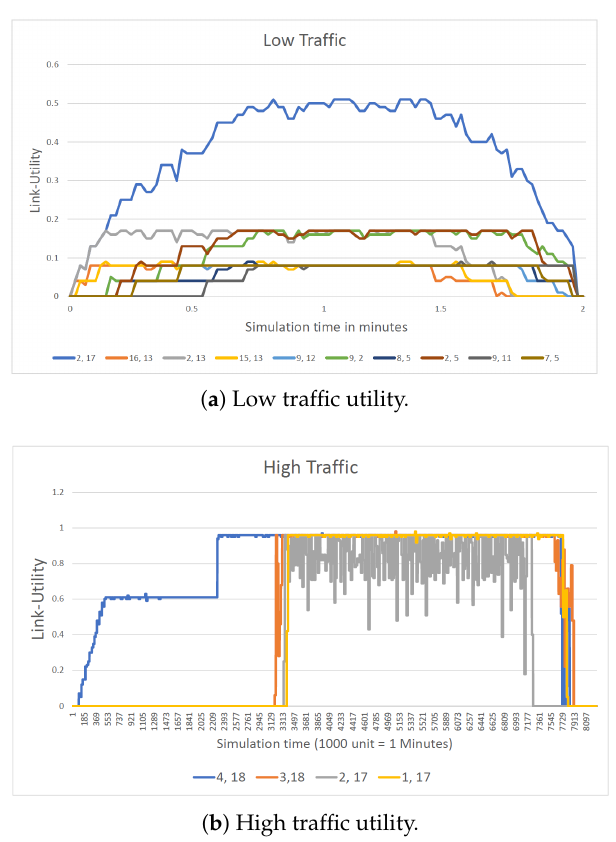
Figure 4. The link utilization is illustrated for both scenarios. The utility is less than the threshold for low traffic and it exceeds the threshold for high traffic